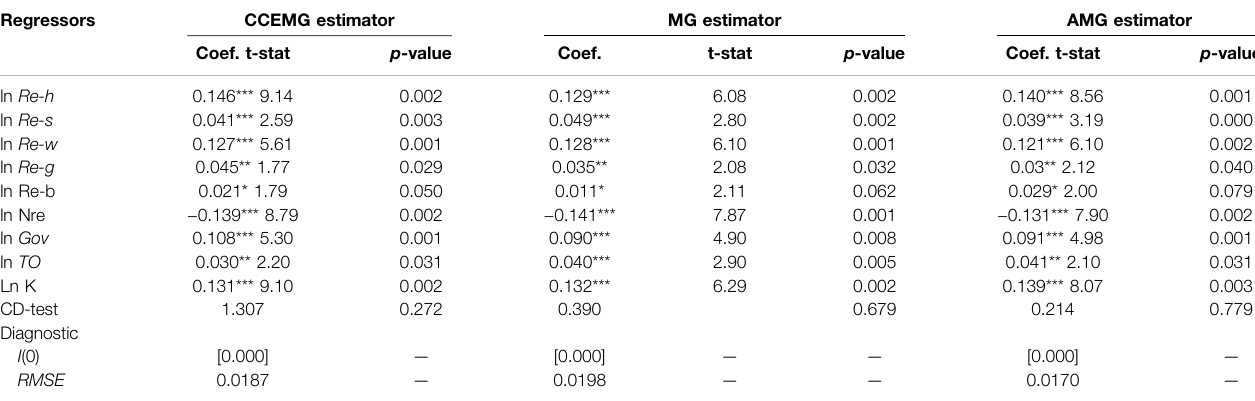
TABLE 5 | Long-run empirical estimation.